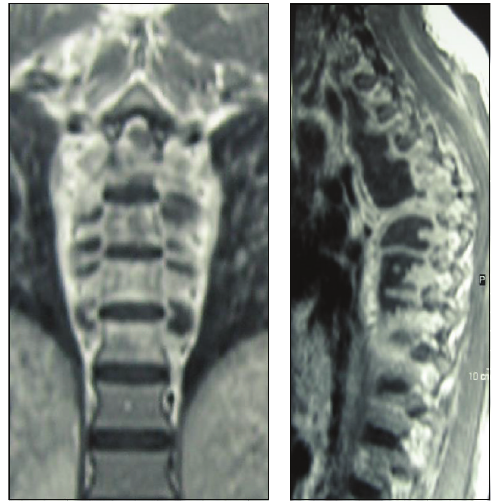
Figure 5: MRI with gadolinium showing a paravertebral abscess.